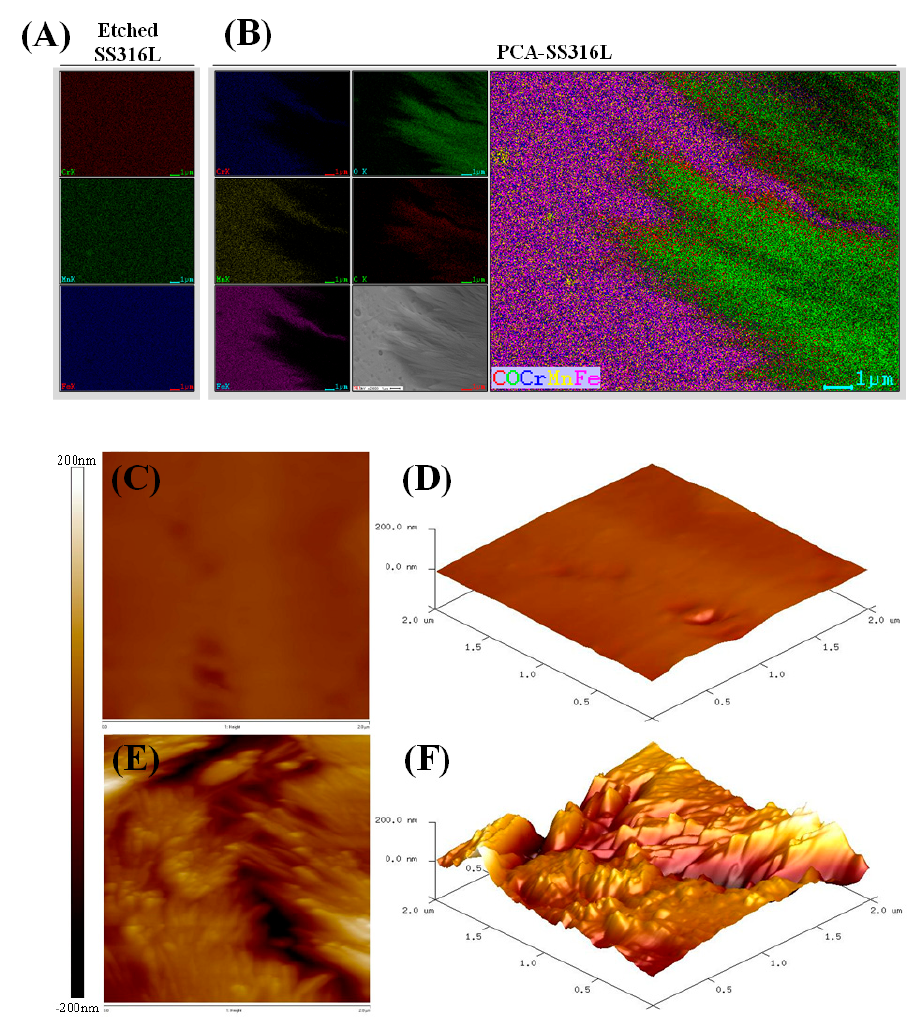
Figure 3. Surface analysis via ( A , B ) EDS mapping of the elemental species on the surface of etched stainless steel 316L and stainless steel 316L coated with polycaffeic acid. Two-dimensional (2D) and three-dimensional (3D) surface atomic force microscopy (AFM) images (2 µm × 2 µm); ( C , D ) etched stainless steel 316L foil; and ( E , F ) stainless steel 316L foil coated with polycaffeic acid.